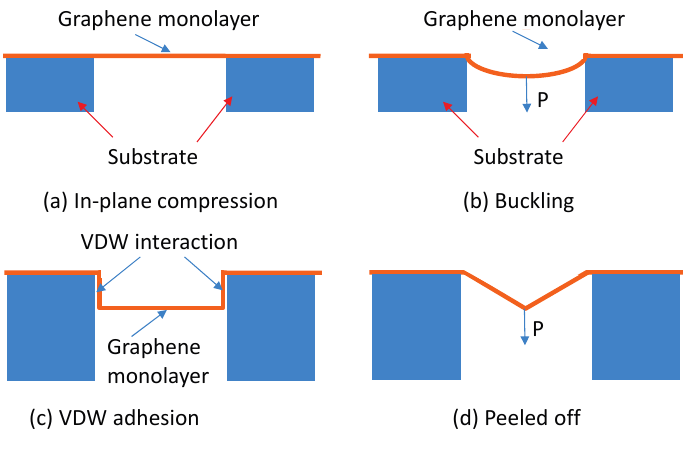
Figure 13. Schematic of the creating mechanism of the true boundary condition of graphene in free standing indentation: ( a ) In-plane compression; ( b ) Buckling; ( c ) Adhesion by the vdW interaction between substrate wall and graphene; and ( d ) Peeled off by the indentation